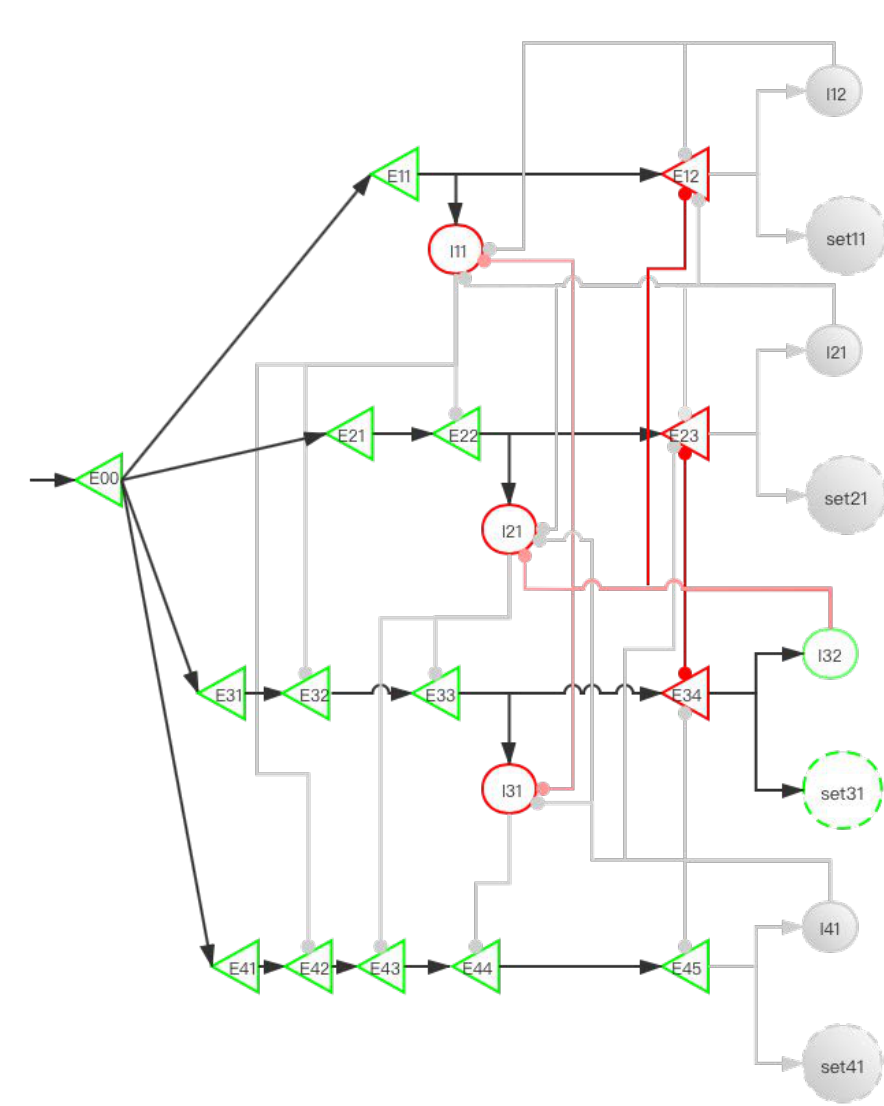
Figure 10. The activity of neurons in the time period from the activation of set31 by the third signal to the activation of E45 by the fourth signal (before set41 is activated). When E34 is activated, I32 inhibits I11, I21, and I31. E12, E23, and E34 have the same effects as Figures 8 and